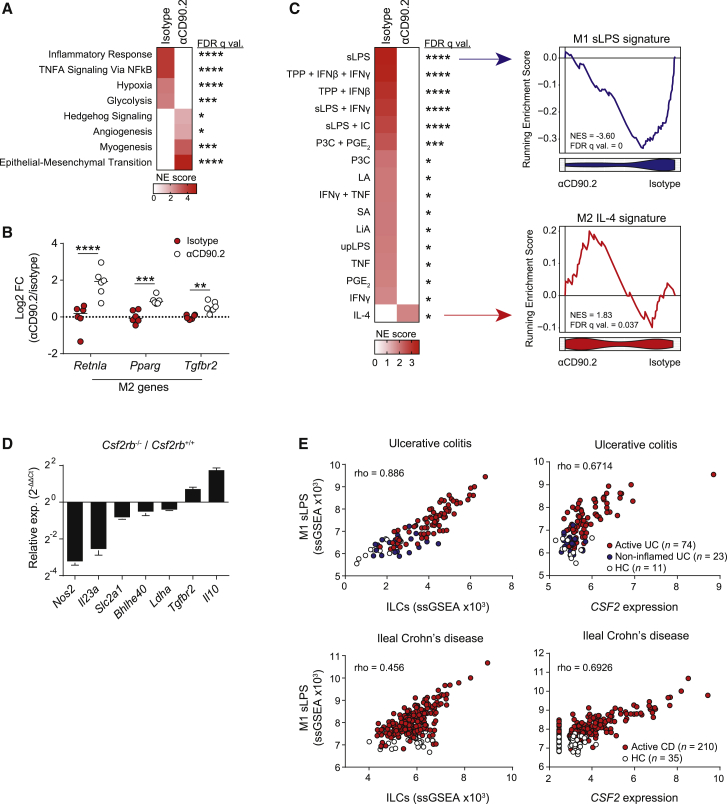
ILCs and GM-CSF Regulate Intestinal Macrophage Polarization(A) GSEA of top Hallmarks pathways in colonic Ly6Clo MHC-II+ MNPs from Rag2−/− mice treated with anti-CD90.2 IgG or isotype control and 2% DSS.(B) Expression of M2 alternative activation genes in colonic MNPs from (A). Medians indicated.(C) GSEA of top 100 DEGs from human monocyte-derived macrophages (MDMs) treated with various stimuli in colonic MNPs from (A). Data derived from GEO: GSE47189.(D) Expression of M1 versus M2 genes between flow-sorted intestinal CD45.1+Csf2rb+/+ and CD45.2+Csf2rb−/− Ly6Clo MHC-II+ MNPs in 80:20 chimeric mice. Data were derived from pooled Ly6Clo MHC-II+ macrophages from 5 mice.(E) Correlation between single sample GSEA scores of ILC (left) or CSF2 levels (right) with M1 signatures in ulcerative colitis (healthy control [HC] n = 11, non-inflamed UC n = 23, active UC n = 74) and ileal Crohn’s disease biopsies (HC n = 35, ileal CD n = 210). Data derived from GEO: GSE59071 and GEO: GSE93624. p values were calculated using the standard DESeq 2 method with multiple comparisons correction using the BH procedure (B), and Spearman’s rank correlation with multiple testing correction (E). ∗p < 0.05; ∗∗p < 0.01; ∗∗∗p < 0.001; ∗∗∗∗p < 0.0001.See also Figure S4.